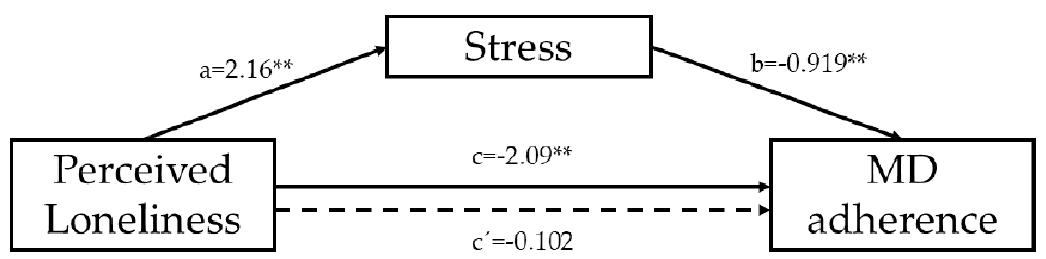
Figure 1. Graphical representation of the mediation effect of Stress in the association between perceived loneliness and adherence to the MD. The numerical values correspond to the unstandardized regression coefficients. Dashed line represents the mediated association. ** p <